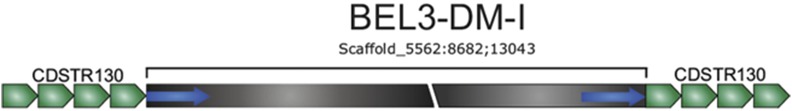
Schematic representation of the BEL3-DM-I transposable element present on RepBase, which is flanked by CDSTR130 satDNA arrays. Blue arrows represent the undescribed 185-bp-long terminal repeat of the BEL3-DM element.